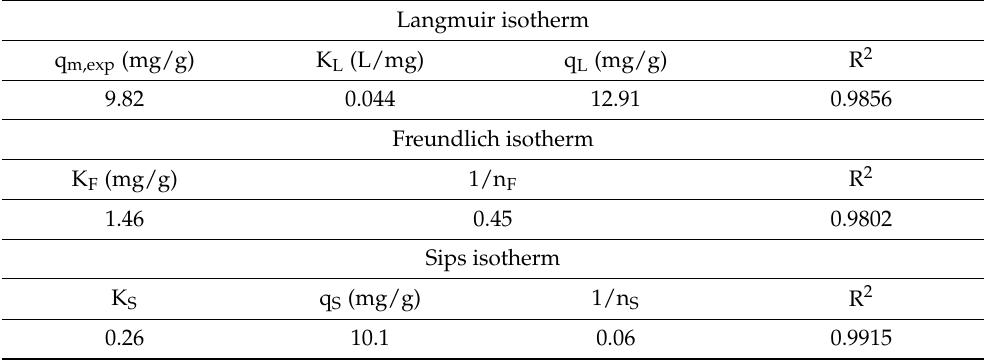
Table 5. Parameters of isotherm model for adsorption Sc(III) onto GDAH-04-300. Langmuir